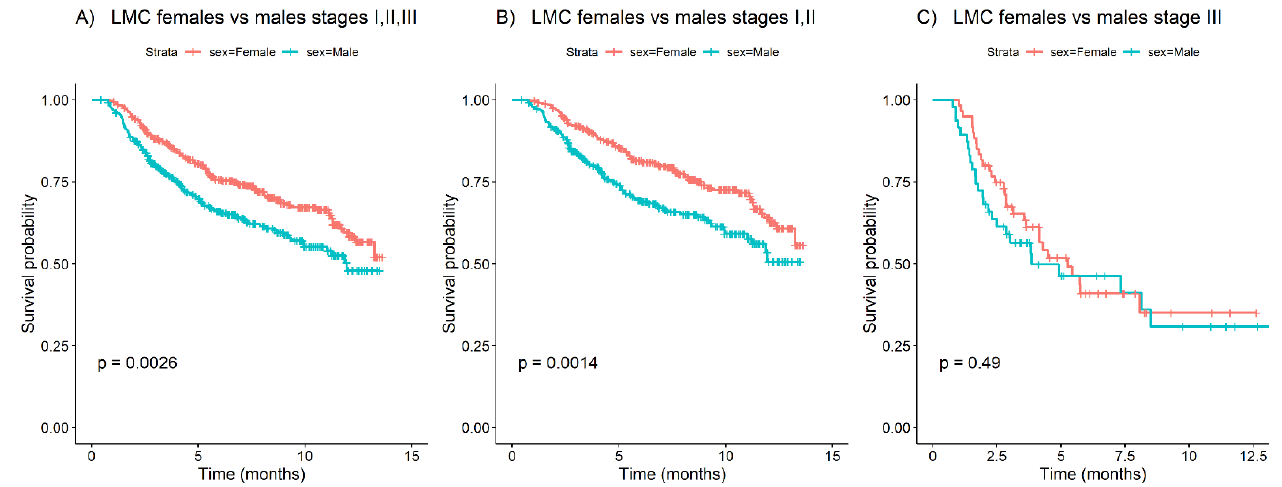
Figure 1. Kaplan–Meier survival curves with the log-rank p -value test between females and males of the LMC dataset on: ( A ) stages I, II, and III combined; ( B ) stage I, II; and ( C ) stage III. Univariate Cox regression analysis applied to the LMC dataset, without stratifying for stages, revealed that the genes associated with survival, either autosomal or sex chro- mosome genes, were more abundant and had higher statistical power within females than in males (Table S1). The same applied when only stage I, II samples were considered. Within the 21 sex chromosome genes associated with survival in stage I, II females, six were